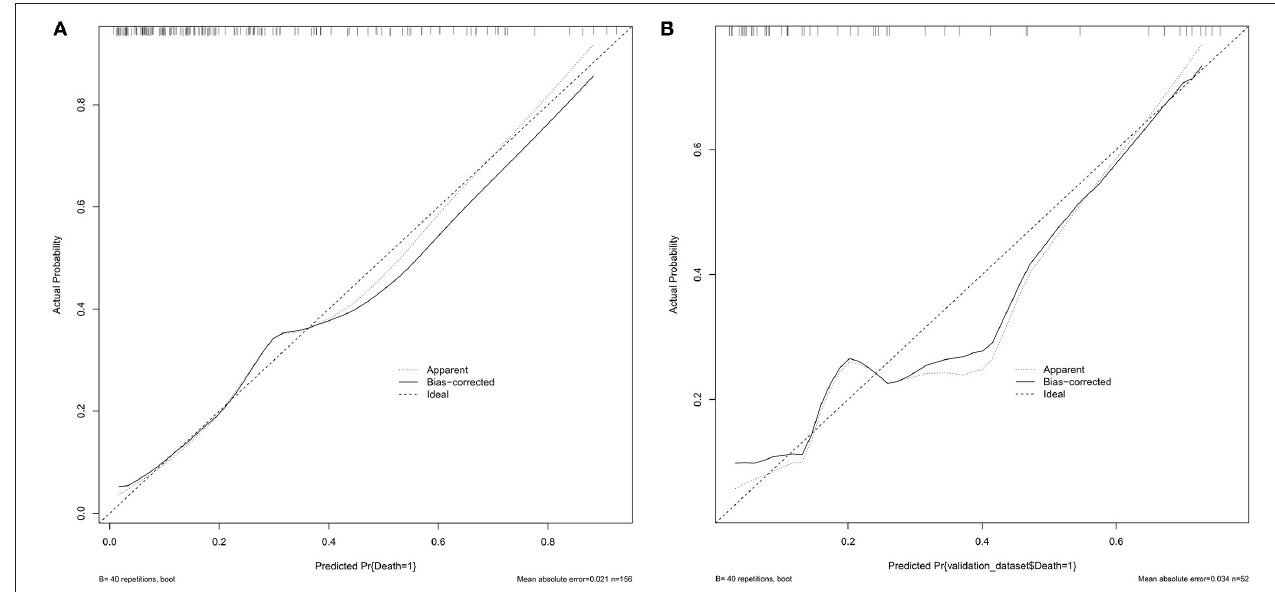
FIGURE 6 | (A) Calibration plots of the proposed nomogram in the training set. (B) Calibration plots of the proposed nomogram in the validation